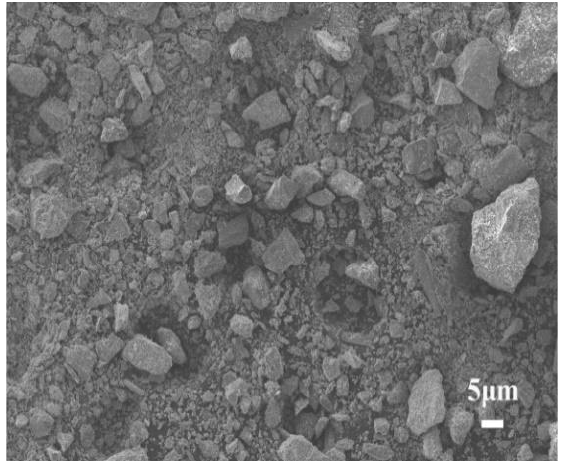
Figure 2. SEM image of STs.